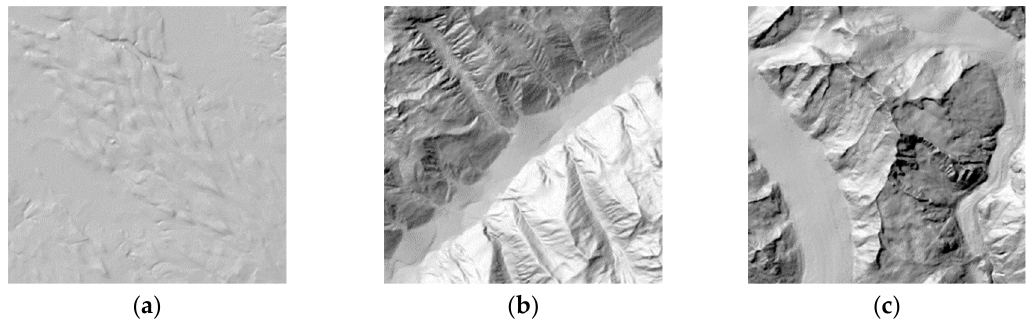
Figure 5. Standard hillshading with NW illumination of sample areas with: ( a ) drumlins; ( b ) alluvial fans; ( c ) glaciers.